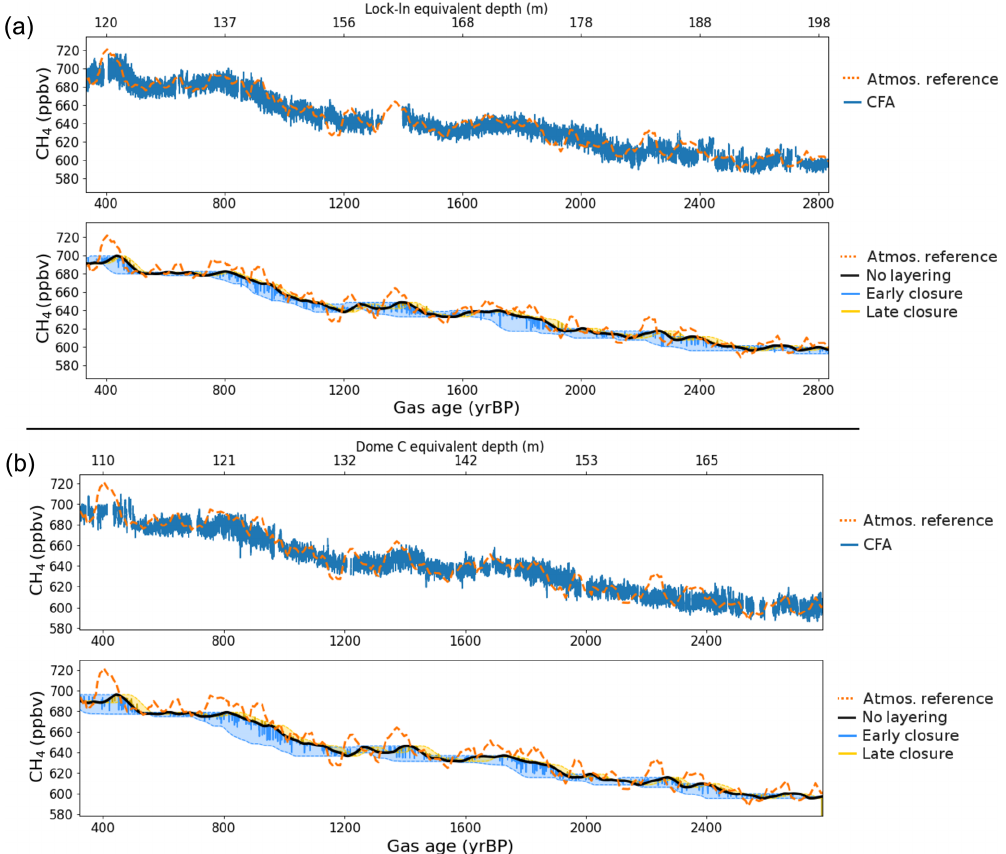
Figure 3. Measured and modeled modern (a) Lock-In and (b) Dome C methane profiles. For each ice core, the upper panel shows the high- resolution methane measurements in light blue and the atmospheric reference in orange. The lower panel for each ice core shows the layering artifacts model results. The black curve is the expected signal without artifacts. The blue and yellow spikes are the randomly distributed, modeled early- and late-closure artifacts, respectively. The blue and yellow shaded areas, respectively, correspond to the modeled range of early and late artifacts with density anomalies up to 2 standard deviations. The dashed orange curve is the record used as the atmospheric